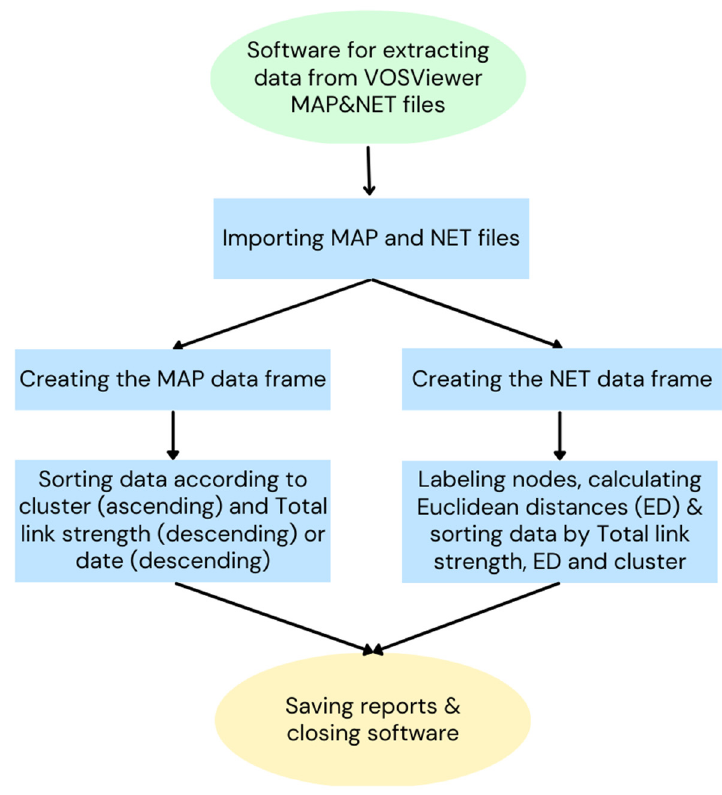
Figure 1. Logical diagram of the developed